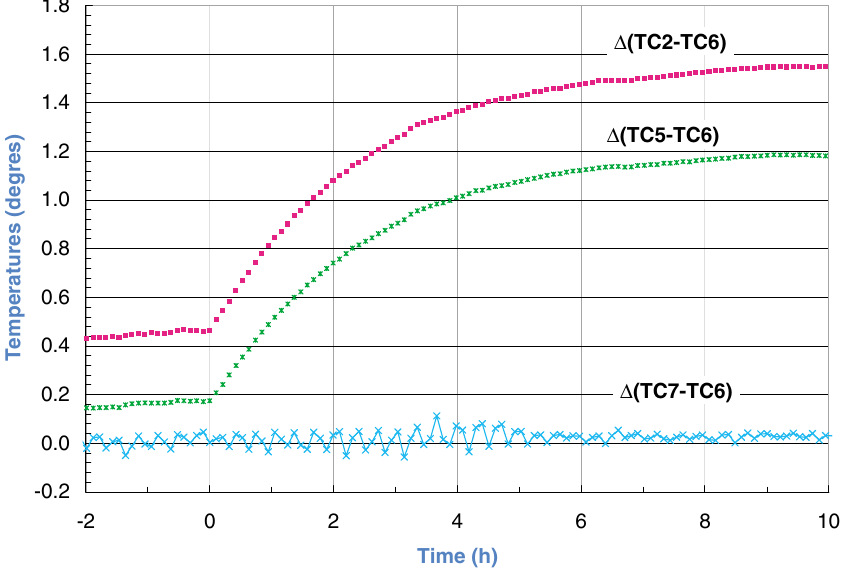
FIG. 3. (Color) Typical in situ calibration cycle. The relative temperature increase corresponds to 0 : 1 W = m . The average of the measured slopes is 2 : 7 K W (cid:1) 1 h (cid:1) 1